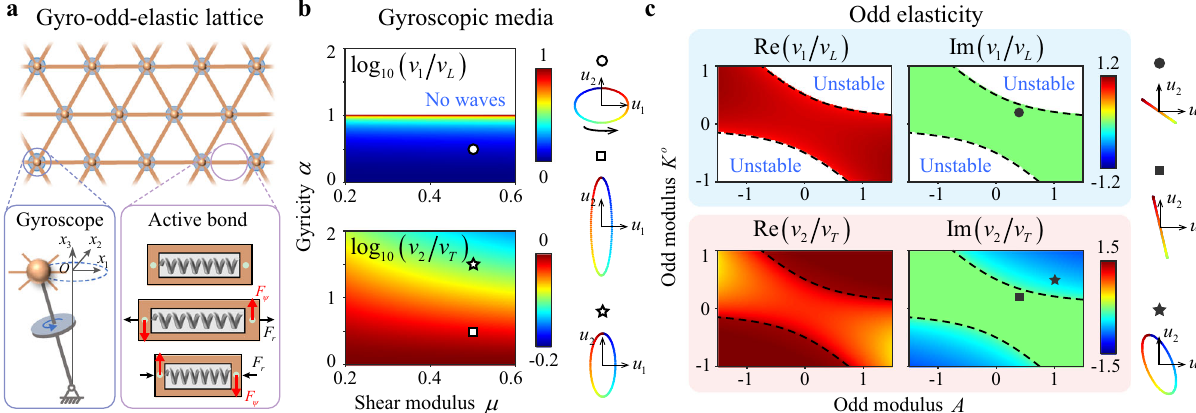
Fig. 1 Active lattice comprising gyroscopic and odd-elastic effects. a A lattice model illustrating how to introduce the two active ingredients: the lumped masses are mounted on spinning gyroscopes to harness gyroscopic coupling. Active bonds that can generate non-conservative forces fuel the odd-elastic response. b Phase diagrams for the two branches of waves in purely gyroscopic media ( A = K o = 0). The colored regions depict the phase velocities v 1 and v 2 . Several points are chosen to show the polarization trajectories, moving from blue to red. c Likewise in b , but now depicting the complex velocities for purely odd elasticity when μ = 0.5 and α = 0. In this fi gure, the blank regions indicate either the absence of waves or mechanical instability. The velocities v v v v 1 / 2 are normalized with their counterparts in passive solids L / T , with the subscript denoting the longitudinal (L) or transverse (T)